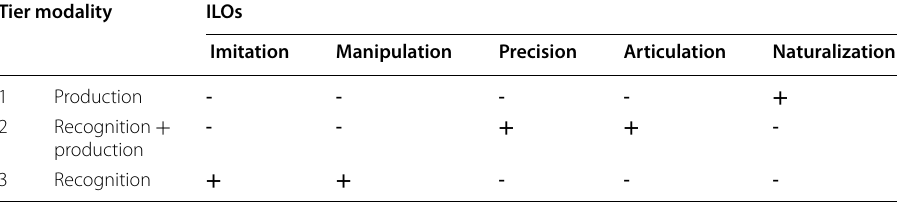
Table 3 Modality and ILOs of the oral tiered tasks Tier